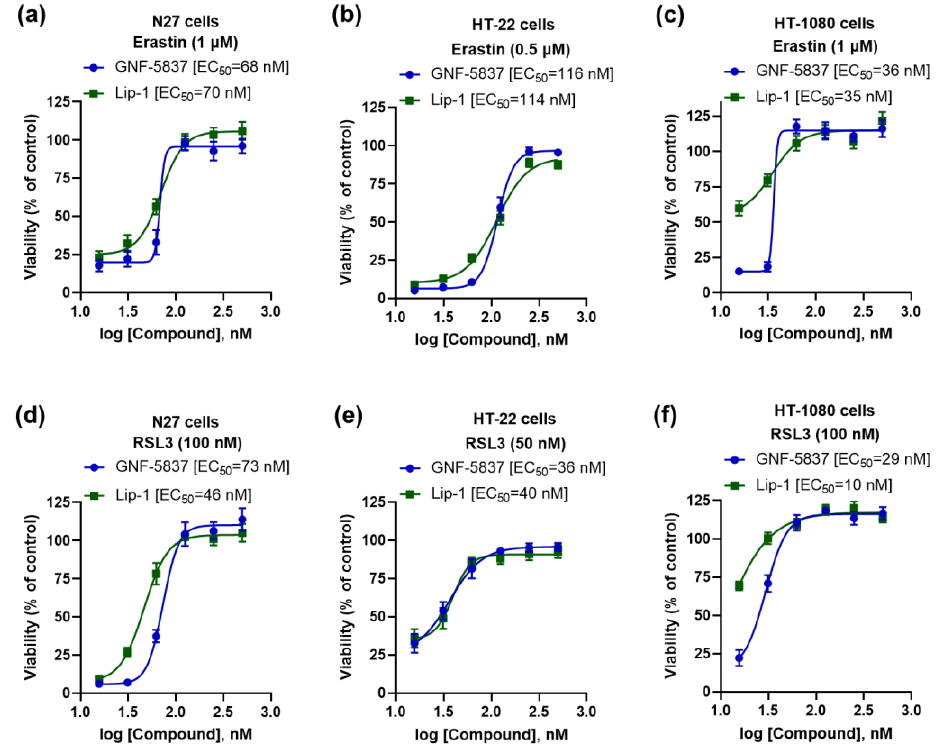
Figure 4. GNF-5837 protects ferroptosis in several immortalised cell lines. Comparative anti-ferroptotic activity between GNF-5837 and Lip-1 for erastin- and RSL3-induced ferroptosis following 24 h incubation in different cell lines: N27, HT-22, and HT-1080 cells ( a – f ). Cell viability was measured by MTT assay. Data points signify mean percentage survival relative to untreated controls ± SEM, n = 11–16 from 3–4 independent experiments.